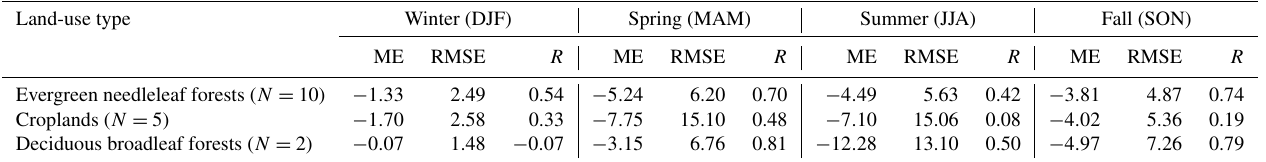
Table B1. Mean error (ME, µmolm − 2 s − 1 ), root mean square error (RMSE, µmolm − 2 s − 1 ) and Pearson’s correlation coefficient ( R ) of daytime means (11–16h) of the CTE-HR biosphere fluxes, compared to flux towers ( N = 17) at similar land-use types, for different seasons. The number provided is the median of the N sites per PFT (in parentheses). Land-use type Winter (DJF) Spring (MAM) Summer (JJA) Fall (SON) ME